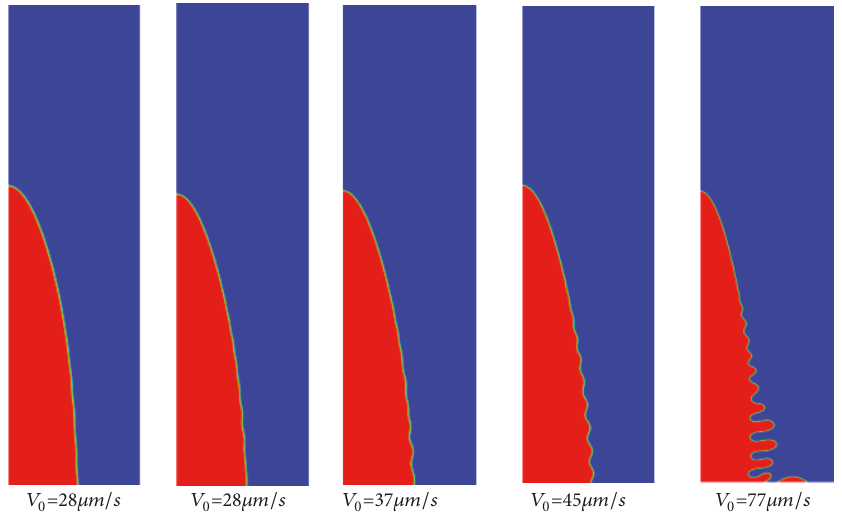
Figure 5: The cellular/dendritic morphologies with different pulling velocities when 𝐺 =5.2 K/ cm .